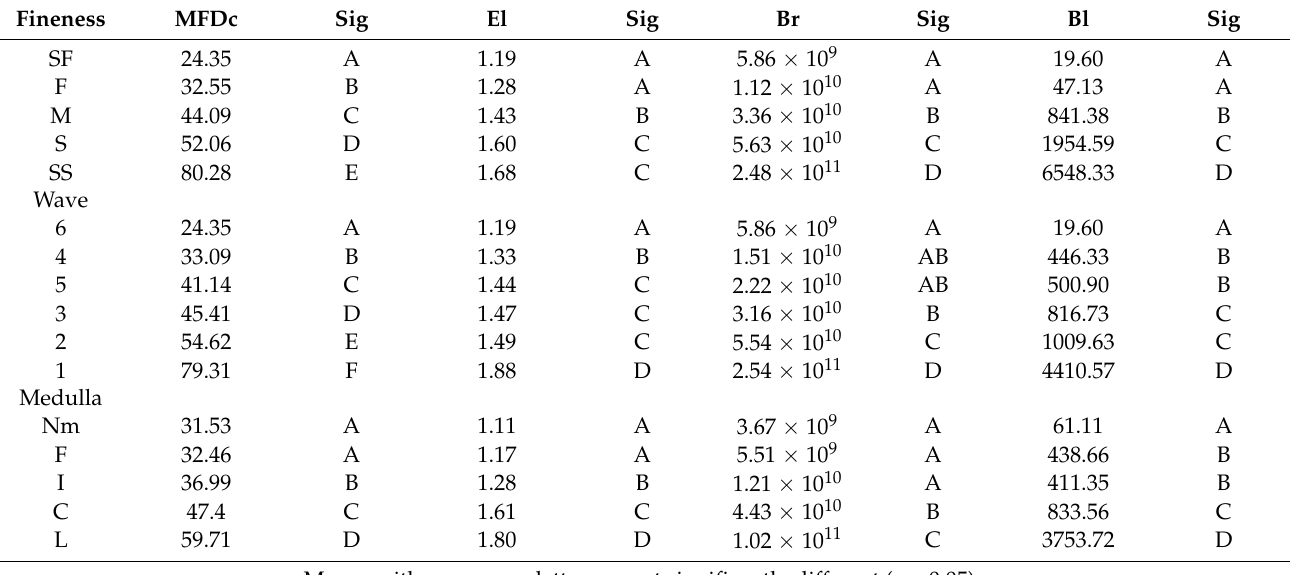
Table 4. The cross fibre diameter (MFDc), ellipticity (El), bending rigidity (Br), and buckling load (Bl) of fibres in relation to fineness, type of wave, and type of